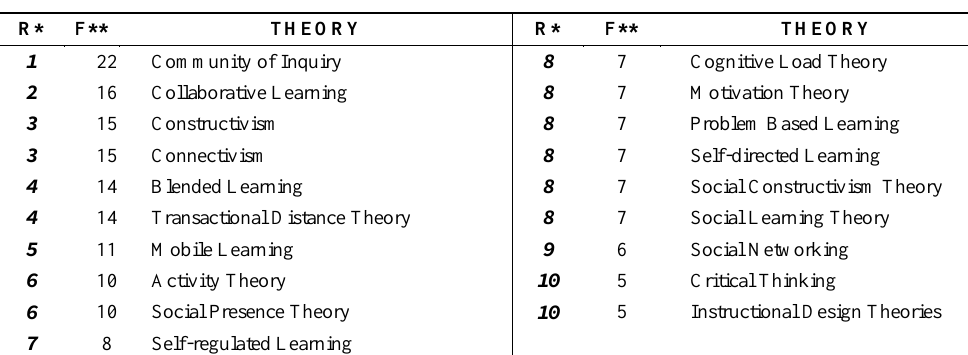
Theoretical/Conceptual